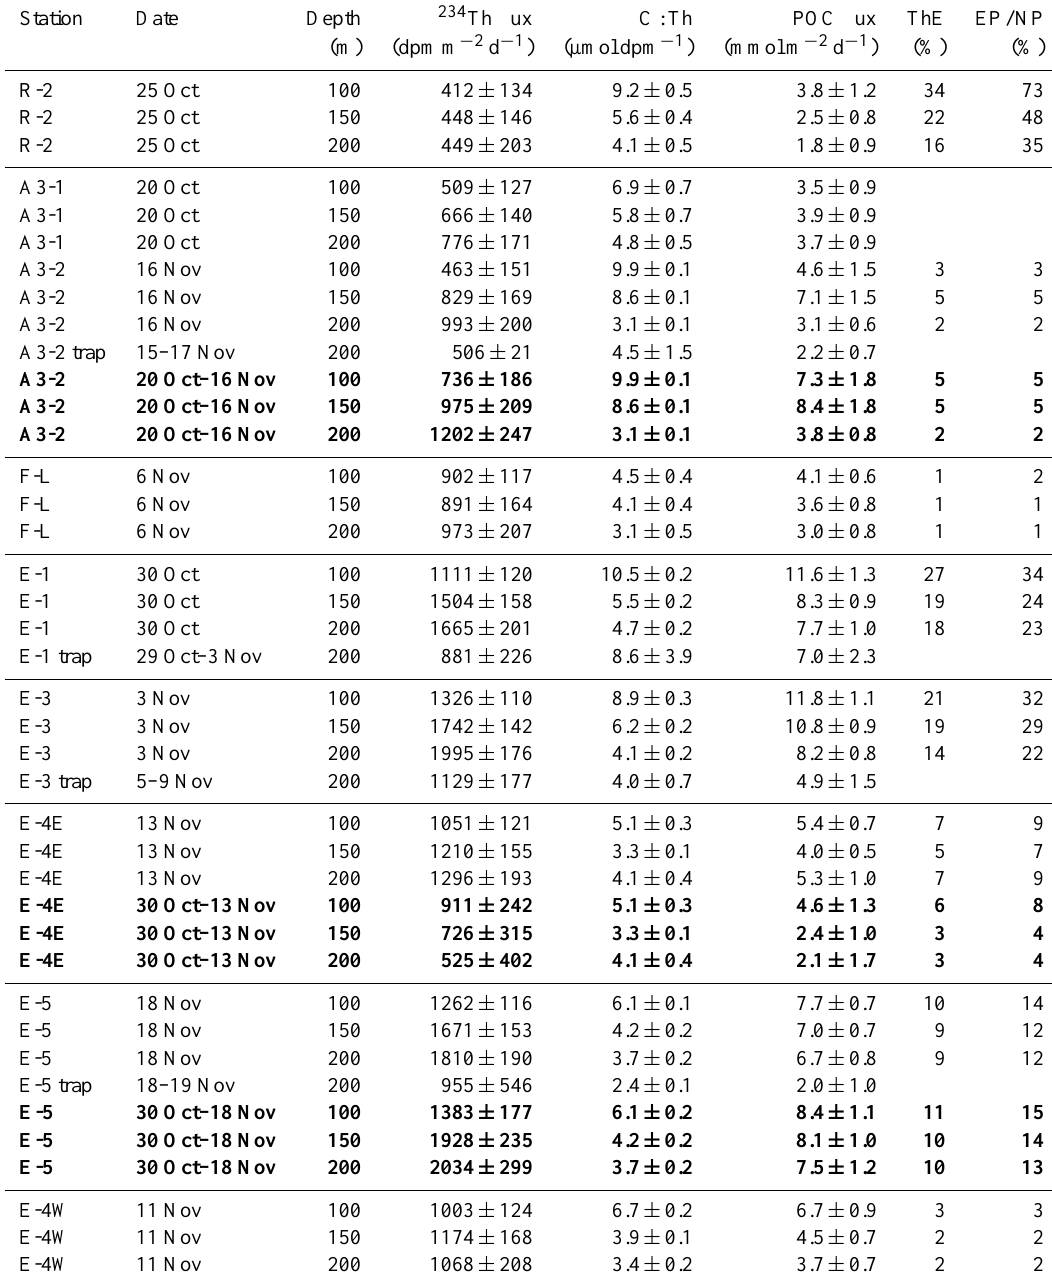
Table 1. 234 Th and POC export fluxes and C:Th ratios of sinking particles estimated at 100, 150, and 200m depth, and carbon export effi- ciency (ThE and export production/new production (EP/NP) ratios) during KEOPS2 (bold text indicates that non-steady state calculations were used). ThE ratio defined as the ratio of POC export to net primary production (NPP) and EP/NP ratio defined as the ratio of POC export to new production